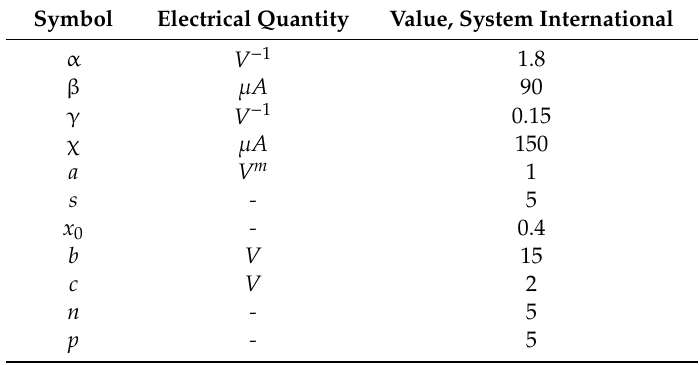
Table 1. Basic parameters and quantities of the applied memristor